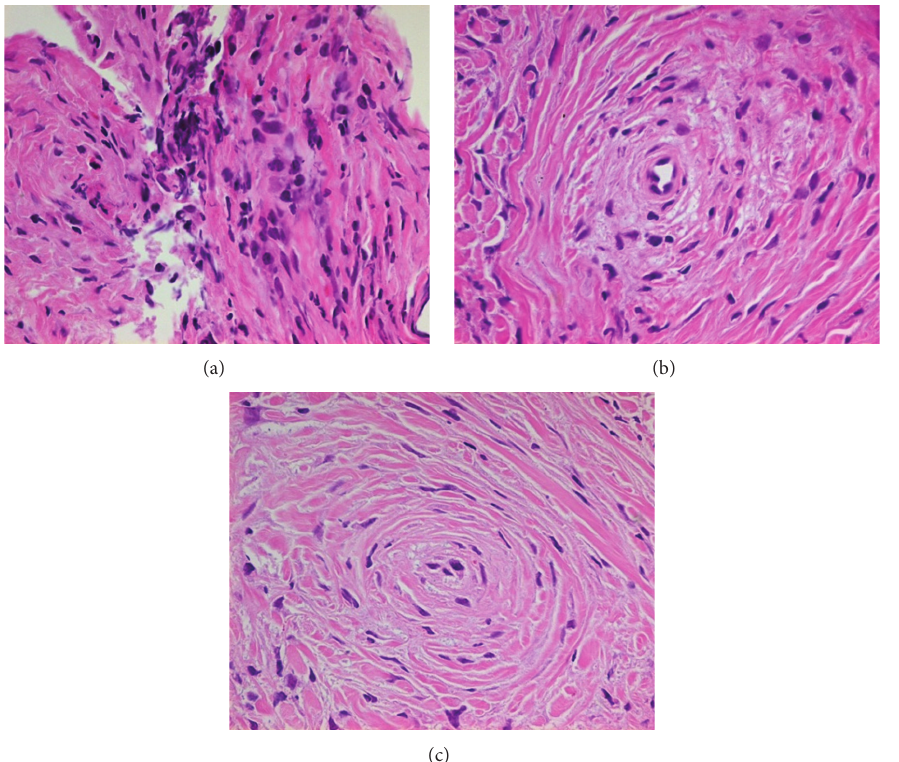
Figure 1: (a) The early inflammatory lesion. It shows the dense inflammatory infiltrate with numerous eosinophils on a background of chronic inflammatory cells. (b) A fibroinflammatory lesion. It is characterized by a whorled appearance perivascular fibrosis which typically surrounded vessels at the center. The predominant infiltration cells are eosinophils. (c) A nodule with onion-skin-type perivascular fibrosis. There might be capillaries and venules in the center of whorly thickening fibrous. Now the blood vessel lumen is obliterated. The inflammatory infiltrate is scanty, but eosinophils remain in the